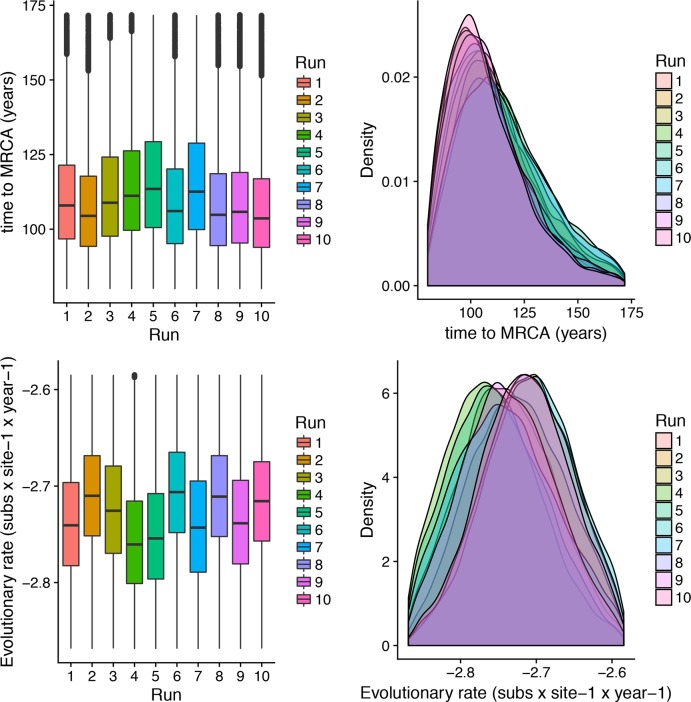
GI-16 genotype MRCA and evolutionary rate.Upper fig: Boxplot (left) and Densityplot of the MRCA posterior probability. Lower fig: Boxplot (left) and Densityplot of the mean evolutionary rate (expressed in base-10 logarithm) posterior probability. Results have been estimated performing ten independent runs based on sequences randomly sampled from the international database. The 95HPD intervals are reported for both figures.